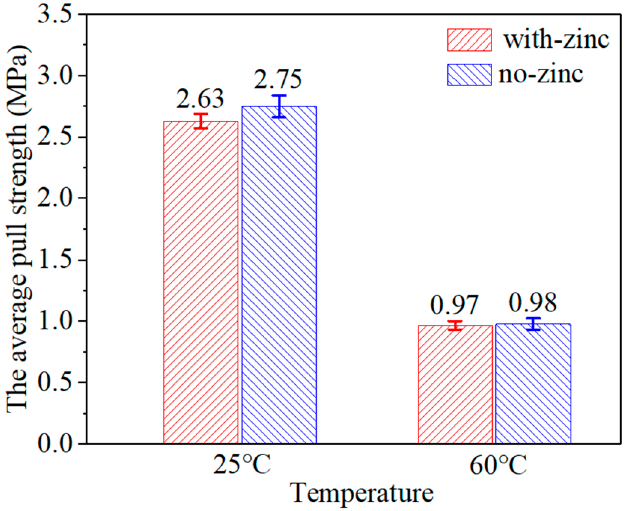
Table 10. Statistics of the failure modes of the with-zinc and no-zinc specimens 1 (at 60 °C).